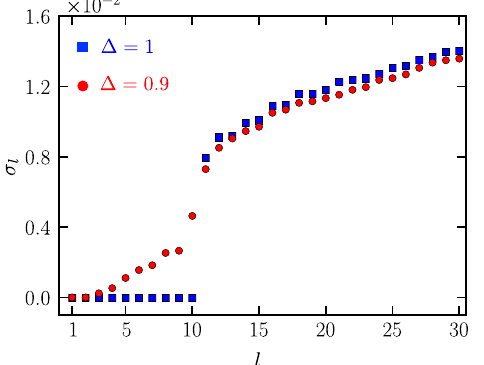
t Þ in a given l ð t Þ : The black l ð